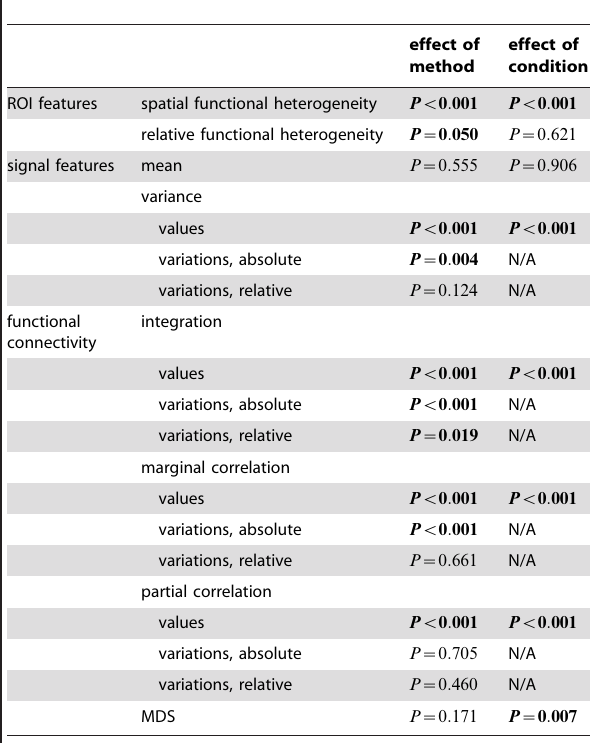
Figure 8. MDS: Effect of condition method by method after MDS on the data from the method only. For each component and corresponding significance level P , we represented { log 10 ( P ) .